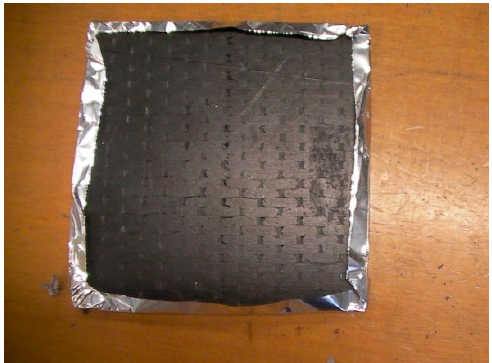
Figure 22. Photographs of the residue of the nanofilled panel after the cone calorimeter test performed at irradiance 35 kW/m 2 . at irradiance 35 kW / m 2